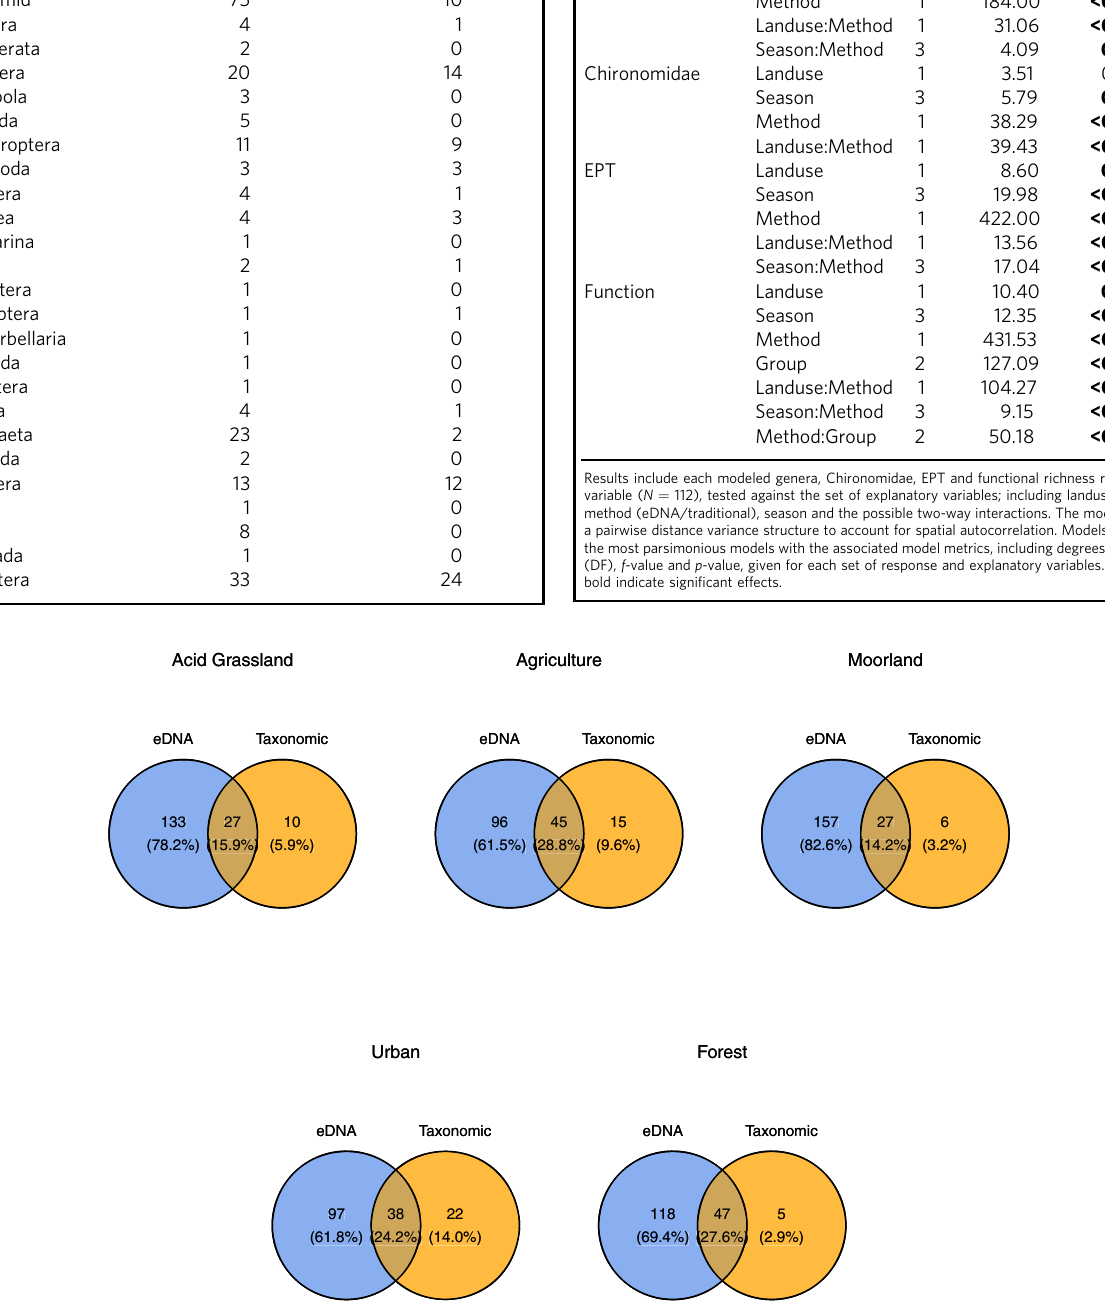
Fig. 3 Traditional vs eDNA biodiversity similarity across landuse types. Venn diagrams showing the proportion of genera detected for each sampling method (eDNA = blue, traditional = orange) across each landuse type. Sample sizes were 56 for eDNA (average of each sites ’ 3 replicate samping) and 56 for traditional sampling.